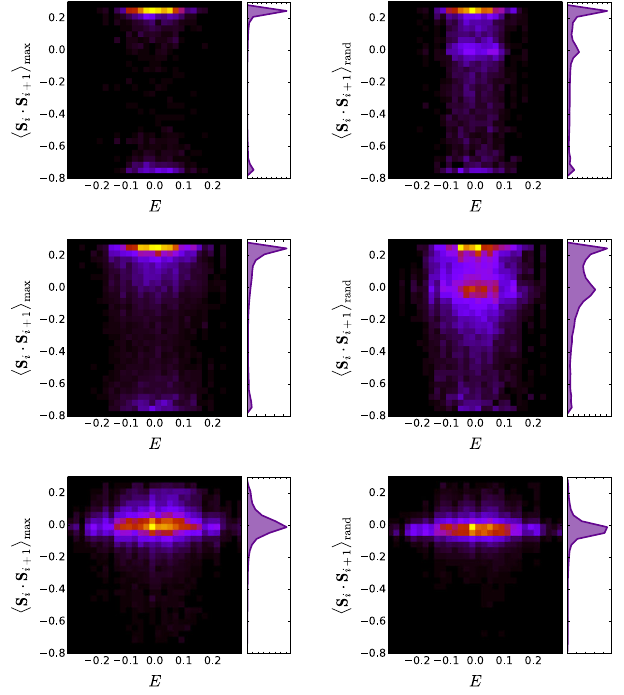
ˆ O a i (left) and max j